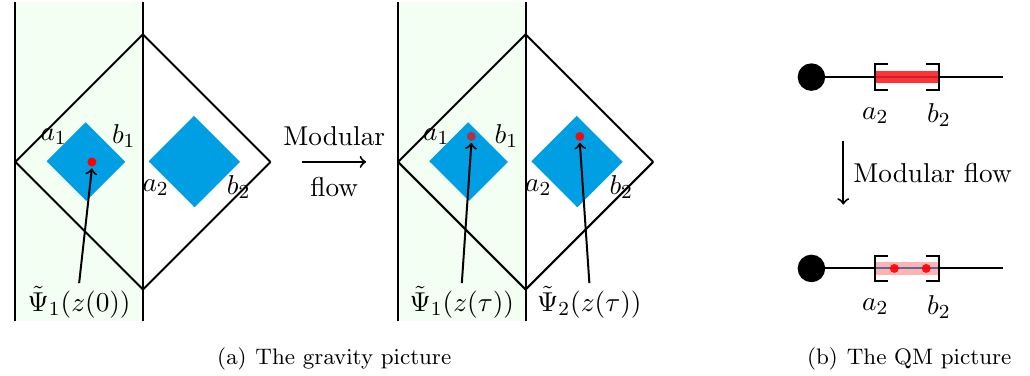
Figure 8 . (a) The gravity picture of the modular (cid:13)ow: a fermion operator in the island is partially pulled out to the bath. (b) The dual quantum mechanical picture: two simple operators (represented by the red dots) are partially pulled out from a complicated operator ~(cid:9) 1 ( z (0)) (represented by the red cloud). Note there are two dots because we have two di(cid:11)erent chiral